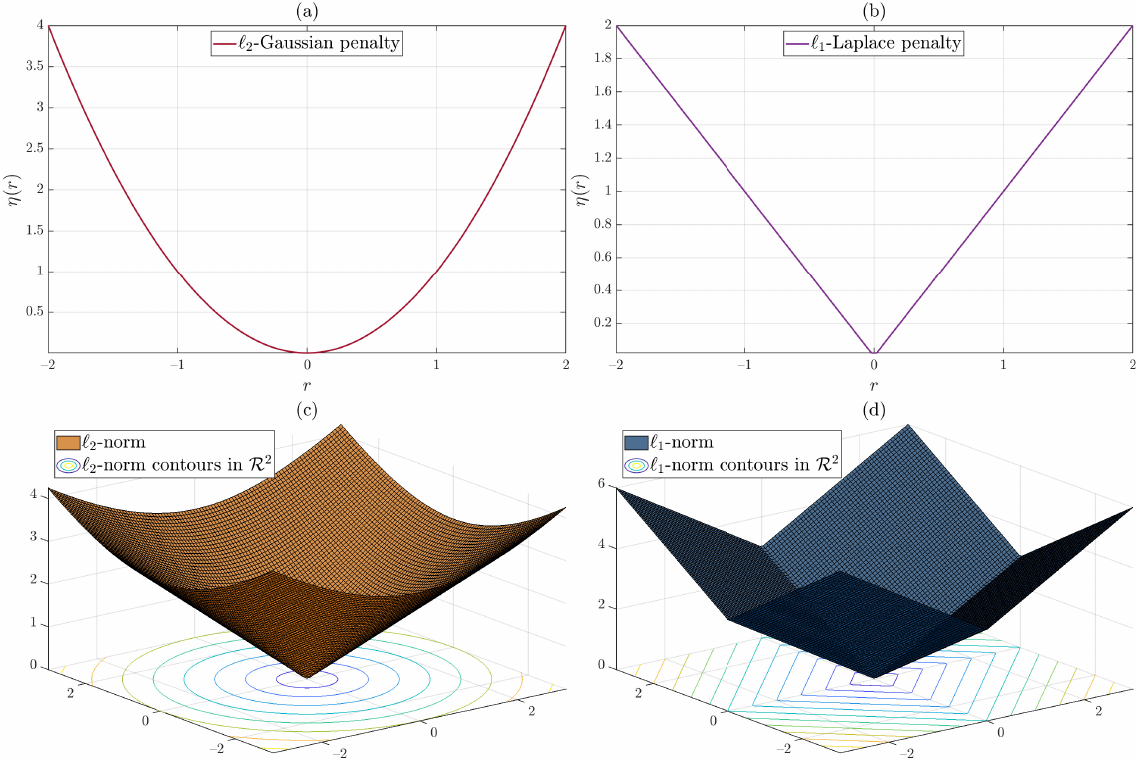
Figure 7. ( a ) (cid:96) 2 -norm penalty corresponding to Gaussian observation noise. ( b ) (cid:96) 1 -norm penalty corresponding to Laplace observation noise. ( c ) (cid:96) 2 norm given by (cid:107) x (cid:107) 2 = contours in R 2 . ( d ) (cid:96) 1 -norm given by (cid:107) x (cid:107) 2 =